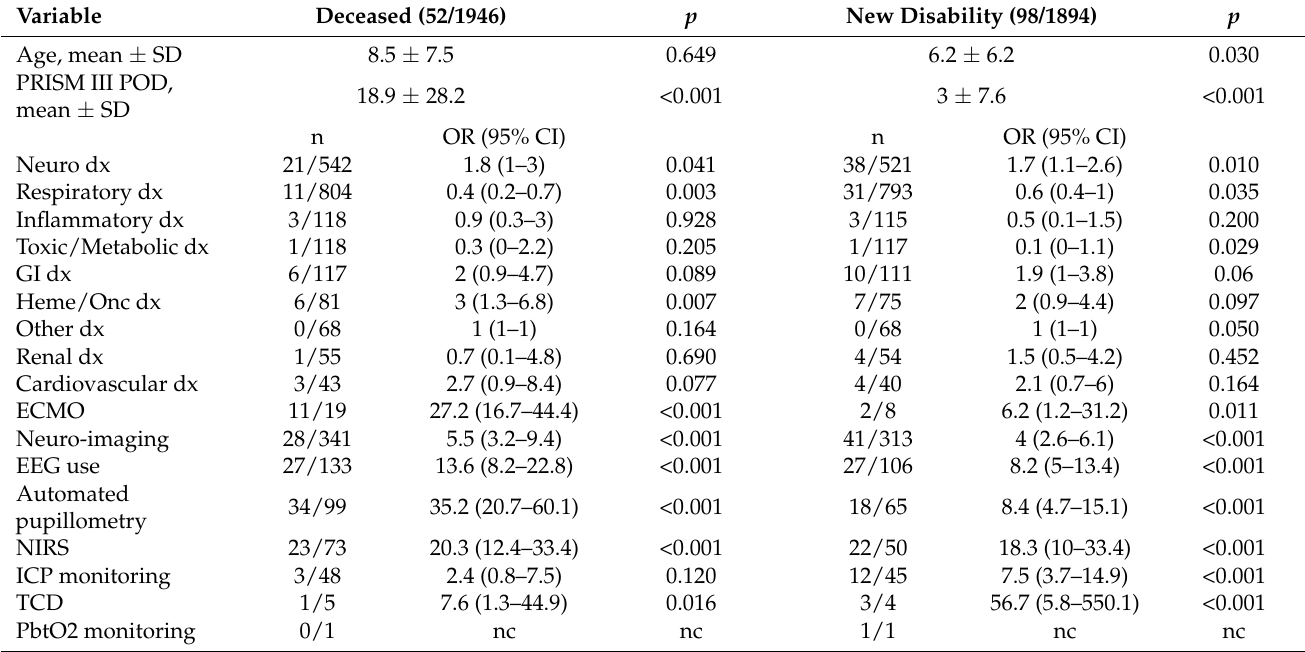
Table 2. Univariate Associations with Hospital Outcome.